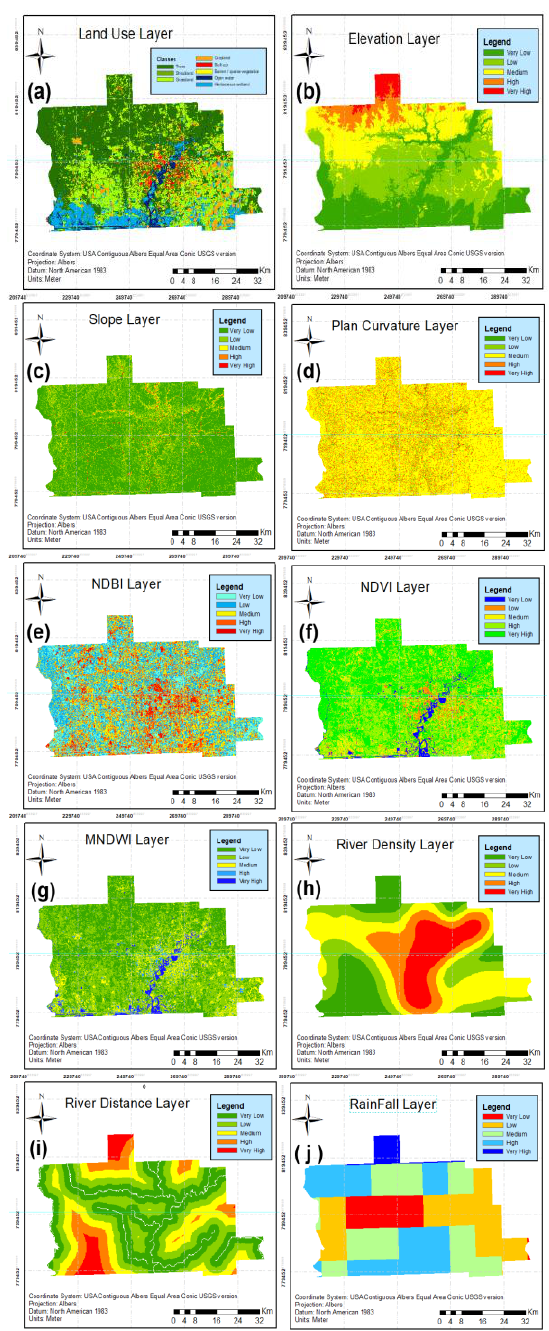
Figure 7 . Set of effecive spatial layers in flooding (a) Land Use, (b) Elevation, (c) Slope, (d) Plan Curvature, (e) NDBI, (f) NDVI, (g) MNDWI, (h) River Density, (i) River Distance and (j) RainFall.